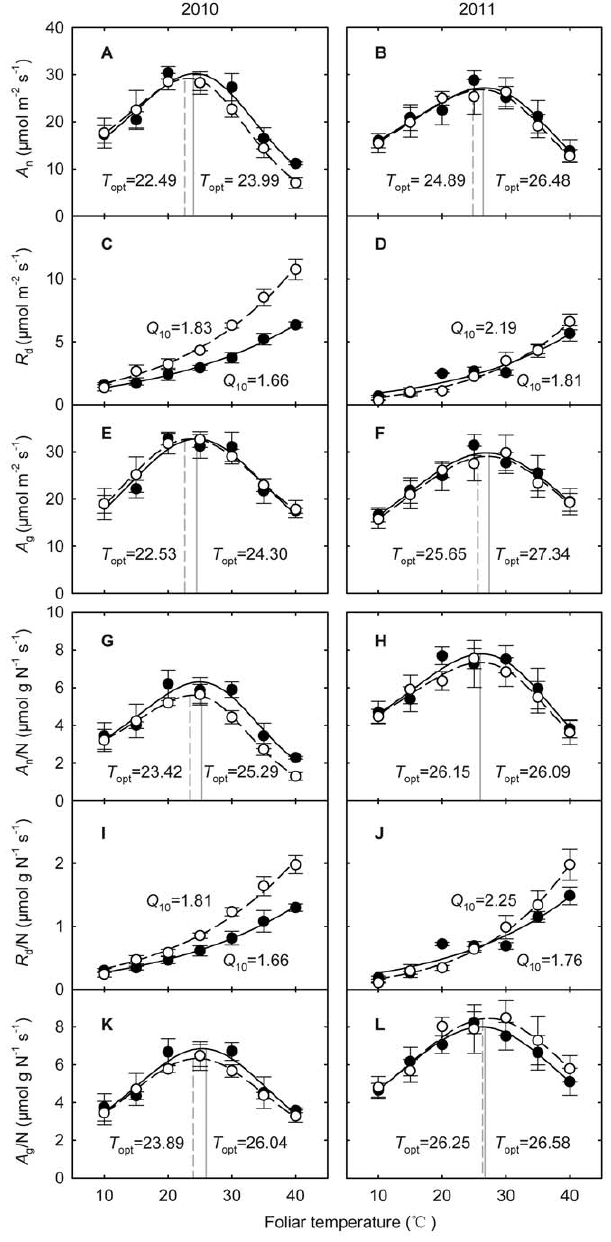
Figure 4. Warming effects on the responses of photosynthesis and respiration to foliar temperature ( T leaf ) in 2010 (left panels) and 2011 (right panels. The filled circles indicate the warming plots and the open circles for the control plots. (A) to (F) foliar area based: (A) and (B) net CO 2 assimilation ( A n ); (C) and (D) dark respiration ( R d ); (E) and (F) gross CO 2 assimilation ( A g ); (G) to (L) foliar nitrogen based: (G) and (H) A n ; (I) and (J) R d ; (K) and (L) A g . Each data point is the average of 4 replicates.